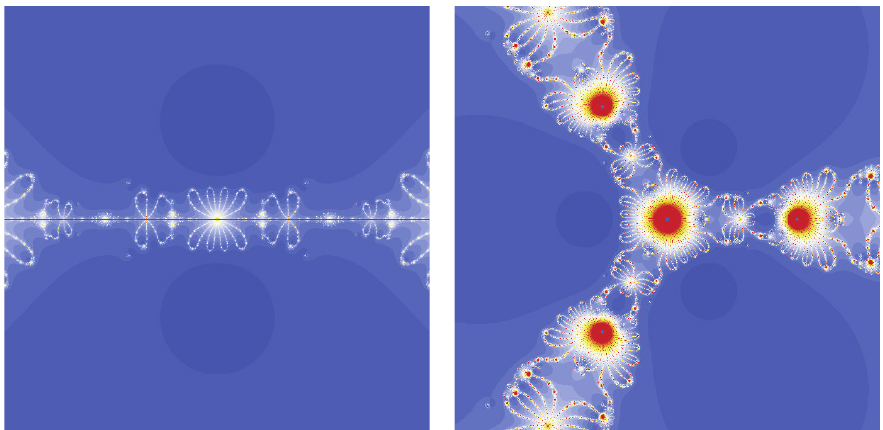
Figure 2: The fractal pictures obtained by (18) using the polynomials 𝑝(𝑧) = 𝑧 2 + 1 and 𝑝(𝑧) = 𝑧 3 + 1 .